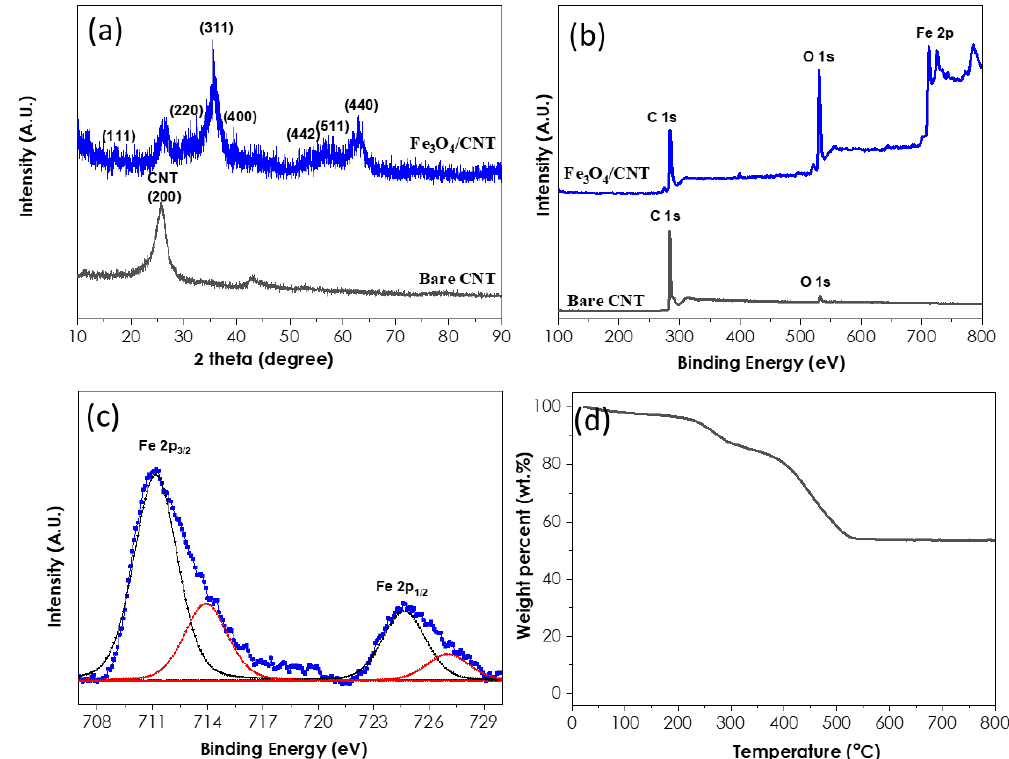
Figure 3. ( a ) XRD patterns and ( b ) XPS survey spectra of bare CNT and nano-Fe 3 O 4 /CNT composite and ( c ) high-resolution XPS spectrum of Fe 2p collected from Fe 2 O 3 -CNT composite. ( d ) TGA curve of nano-Fe 3 O 4 /CNT composite.